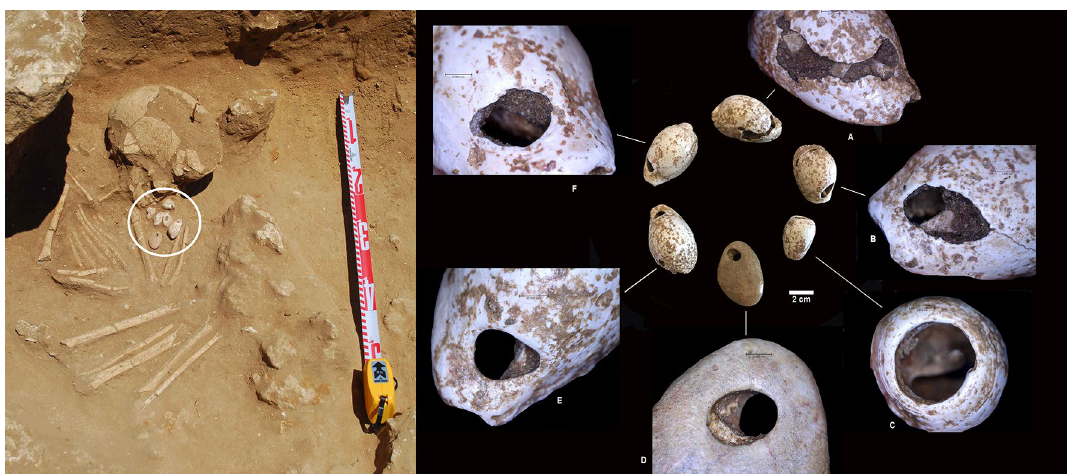
Figure 12. To the left, infant burial E1T17, where a shell necklace was found in situ, near the neck area. To the right, detail of the necklace, formed by four specimens of Zonaria Pyrum ( A , B , E , F ); one of Conus mediterraneus ( C ); and a flat beach pebble ( D